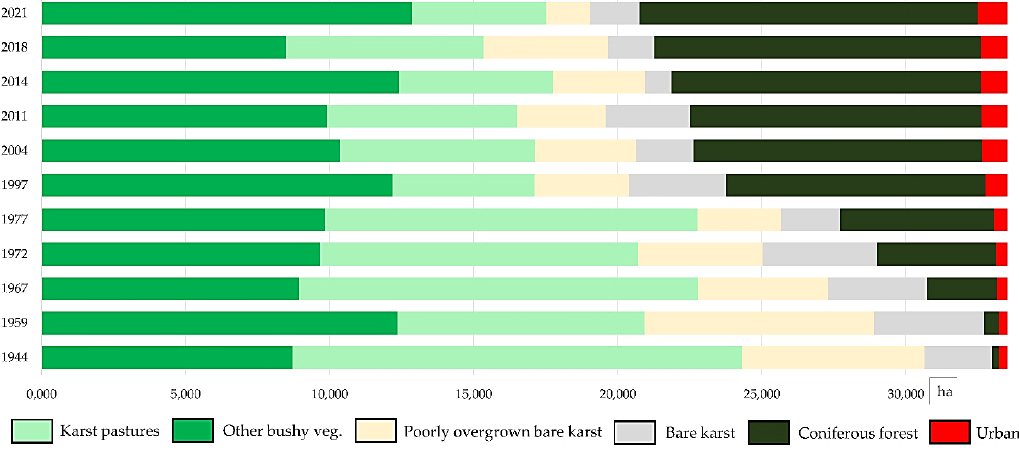
Figure 15. Total area of classes in LU/LC models of Ošljak (1944–2021) .